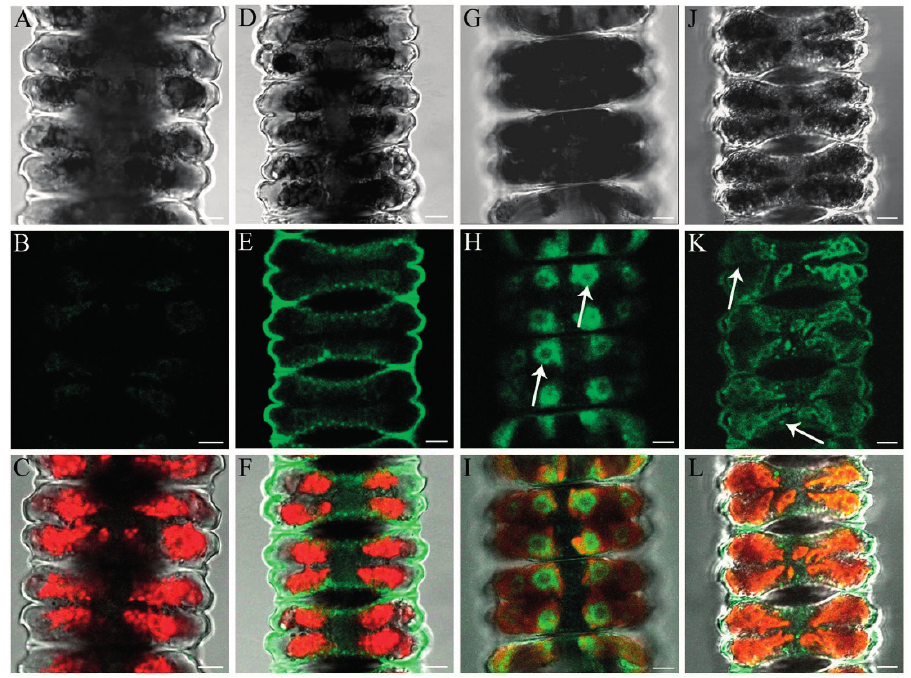
Figure 9. Detection of the distribution of Al and Zn in Desmidium filaments by morin fluorescence in CLSM, in untreated controls and after exposure of the algae to 50 µM Al 2 (SO 4 ) 3 as well as 10 and 50 µM ZnSO 4 , respectively. The first line shows digital interference contrast (DIC) images, the second line presents the morin labeling only, and the third line indicates the merged images (including chloroplast autofluorescence in red). ( A – C ) Controls show no morin staining; ( D – F ) Desmidium filaments treated with Al for 1 h show fluorescence of the cell wall; ( G – I ) After Zn exposure (50 µM) for 1.5 h, pyrenoid regions with surrounding starch grains are labeled (arrows); ( J – L ) After 21 days treatment with Zn (10 µM), the cell wall and a few spots near the chloroplast are stained (arrows). Bars = 5